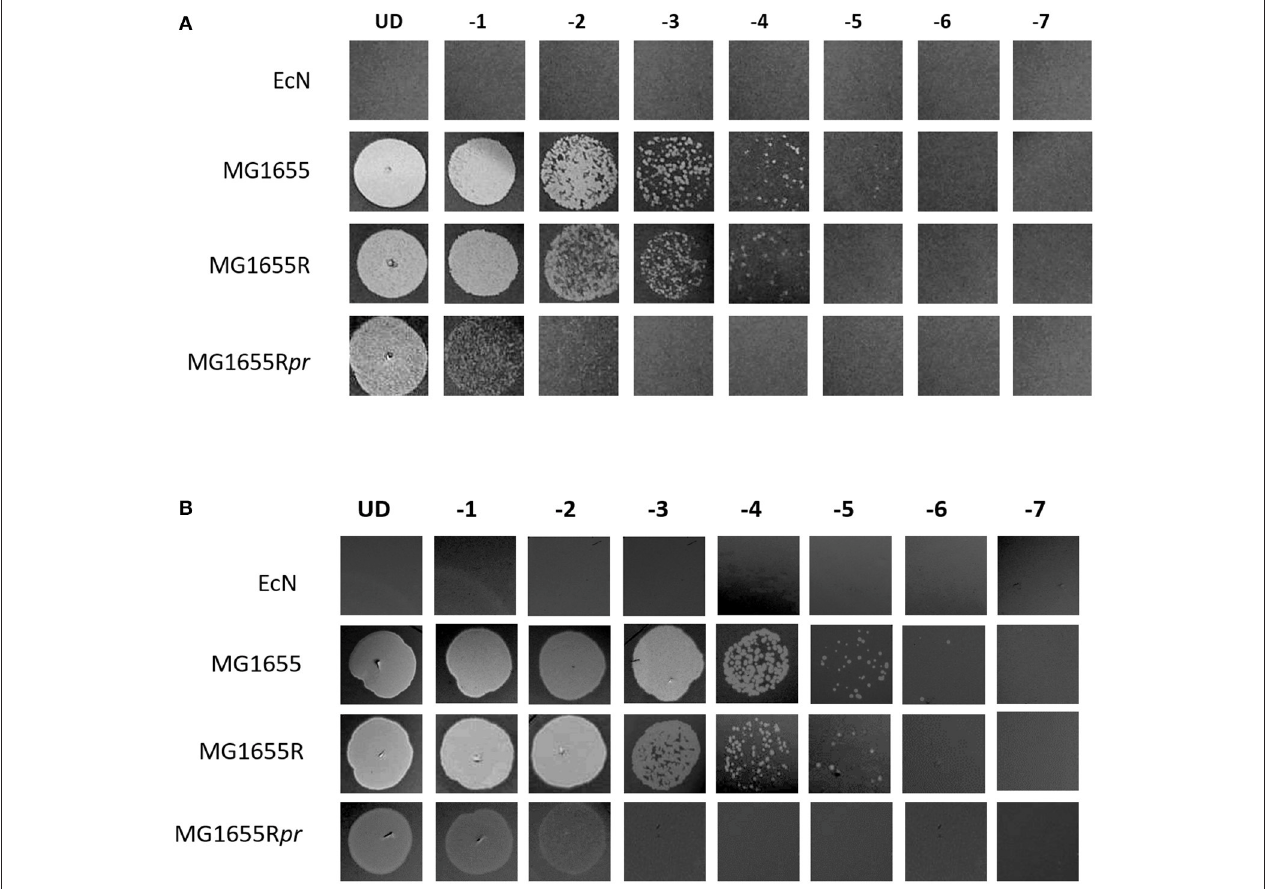
FIGURE 3 | Determination of the protection in MG1655 recombinant strains toward lambdoid phage infection. MG1655 was transformed with pUC19 (MG1655R) with or without the phage repressor ( pr ) gene sequence of EcN (MG1655R pr ). Serial dilutions of stx -phages (A) or lambda-phages (B) in 0.9% saline were dropped on EcN, MG1655 or MG1655 recombinants lawns. Lysis of the respective bacterial strain is visible as lysis zone or individual plaques. UD, undiluted, − 1 to − 7, 1:10 dilution